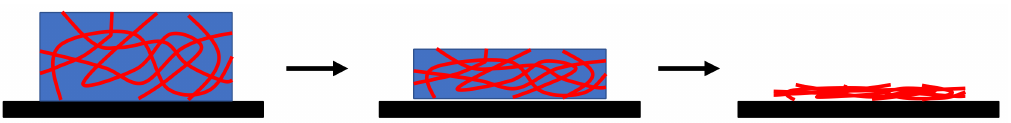
Figure 1. Simplified cartoon showing the collapse of a 3D network to a 2D film on